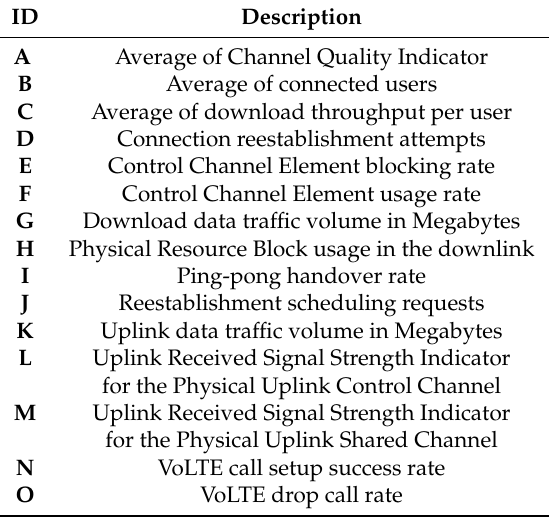
Table 1. Labeled key business related